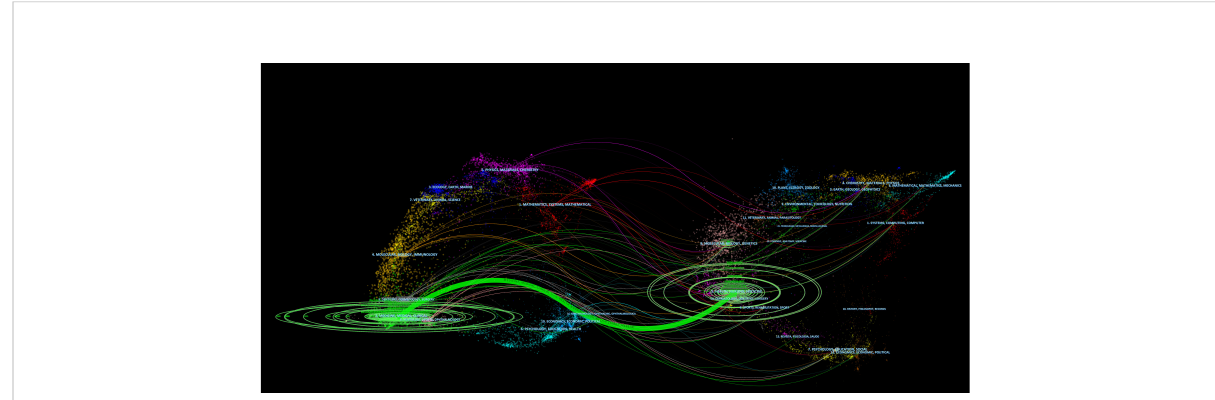
FIGURE 6 The dual-map overlay of journals related to robotic surgery in oncology. The citing journals are on the left of the map, and the cited journals are on the right, and the colored paths represent citation relationships.